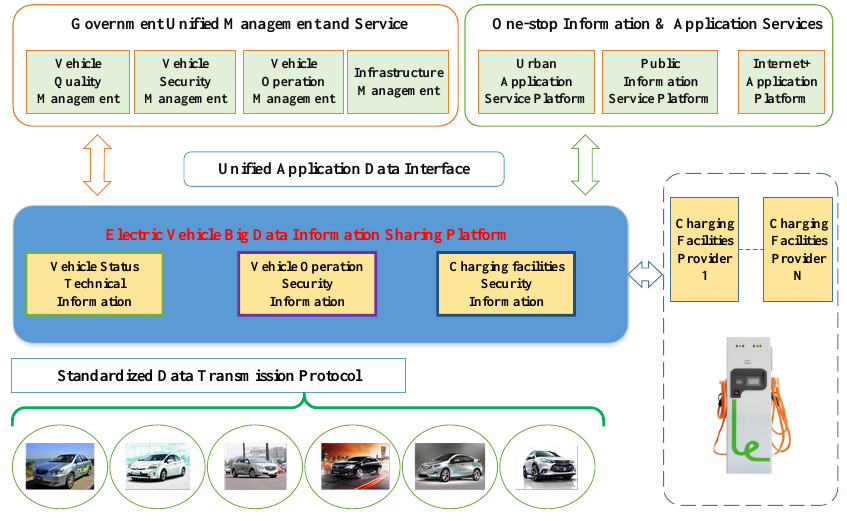
Figure 2. The function of the big data platform.